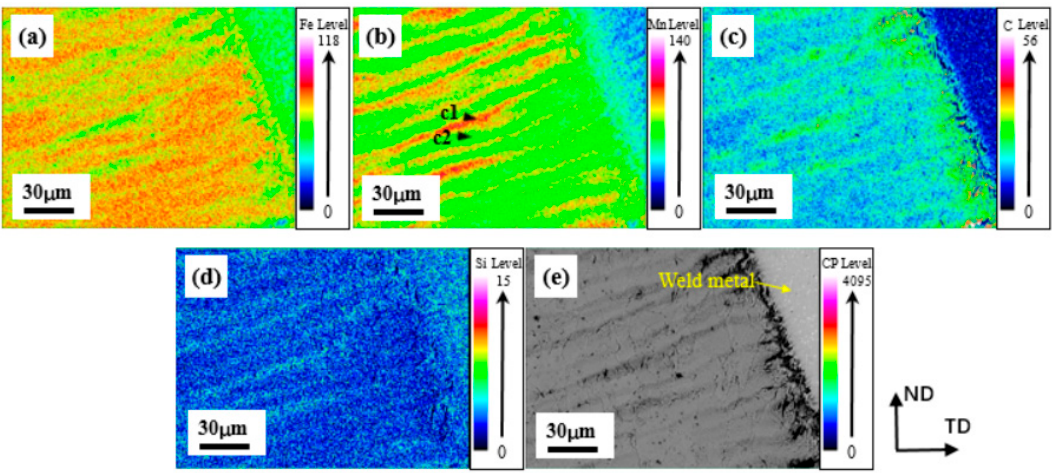
Figure 9. EMPA composition maps of ( a ) Fe, ( b ) Mn, ( c ) C, ( d ) Si elements and ( e ) EBSP in CGHAZ. The c1 and c2 arrows indicate the C-Mn-Si segregation band and C-Mn-Si depletion band, respectively. However, the banded segregation behavior of Mn and Fe elements of the BM (Figure 11) is weaker, and the distribution of C and Si elements in austenitic matrix is homogeneous with respect to